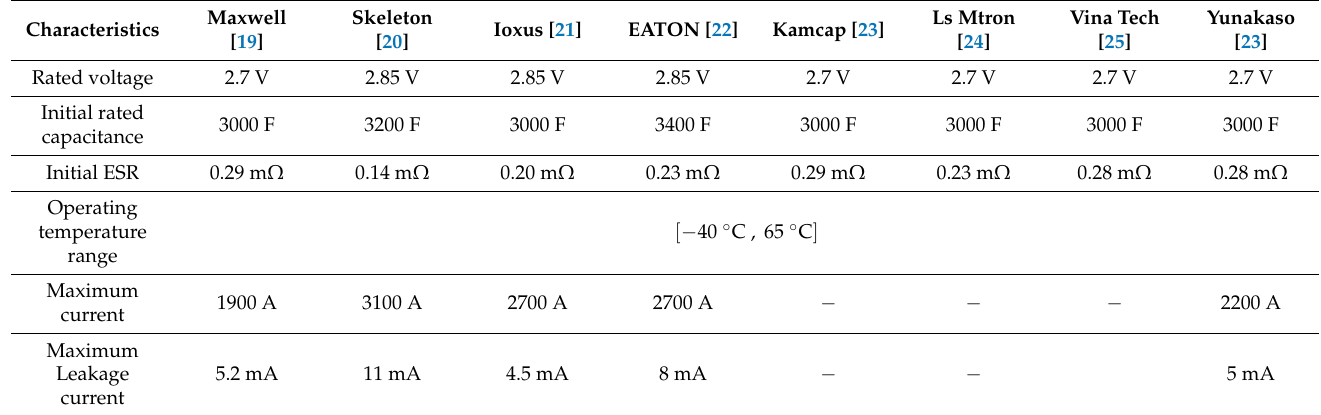
Table 4. Main parameters of SCs cell for different manufacturers.